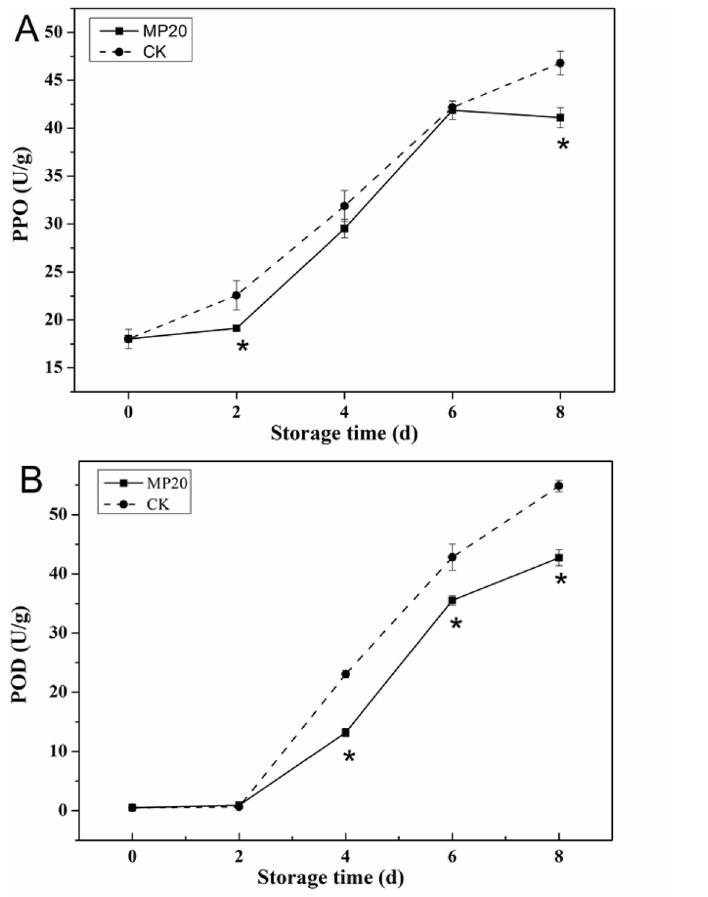
Figure 5. Effect of packaging on PPO activity ( A ) and POD activity ( B ) of mulberry leaf vegetable during storage. Error bars indicate standard deviation. Asterisks indicate significant differences at the same storage time ( p <